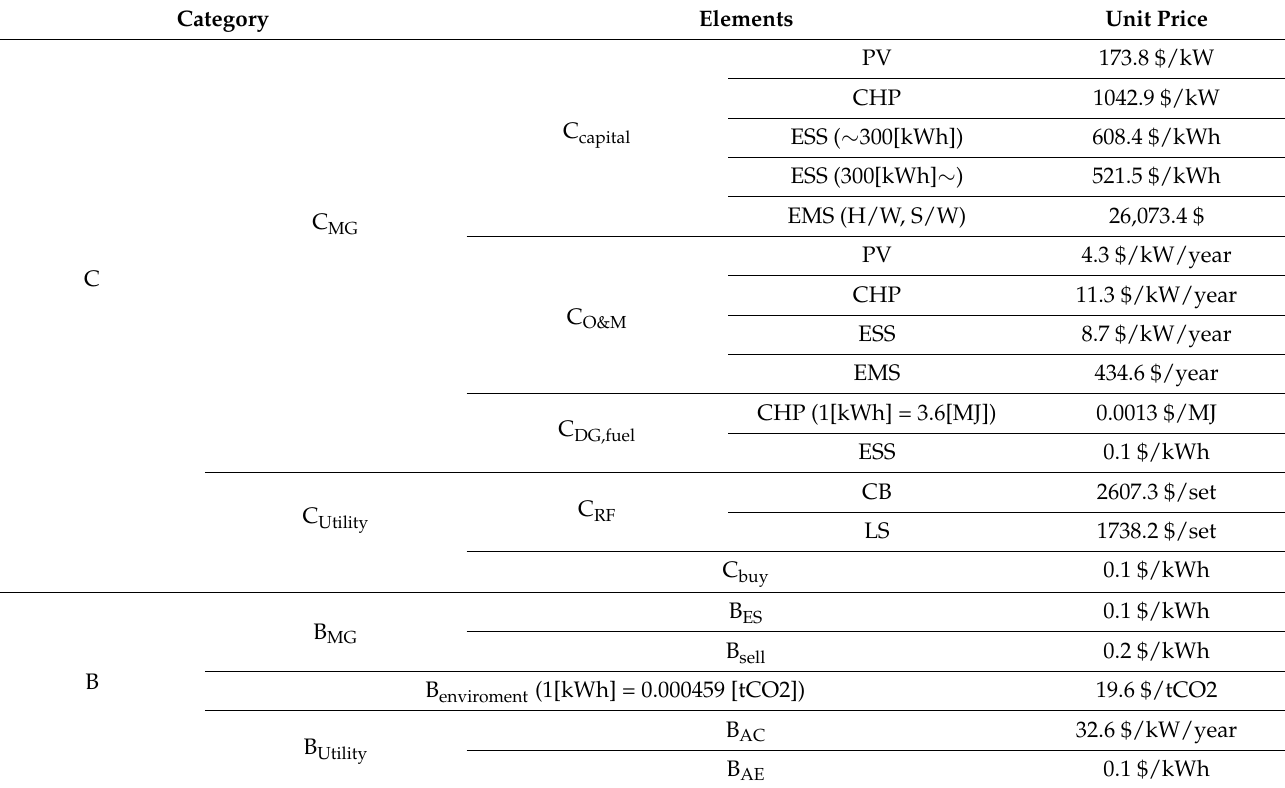
Table A2. Unit price of cost and benefit elements